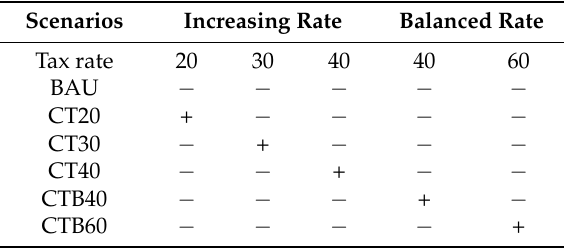
Table 3. The design of different scenarios of imposed carbon tax. Scenarios Increasing Rate Balanced Rate Tax